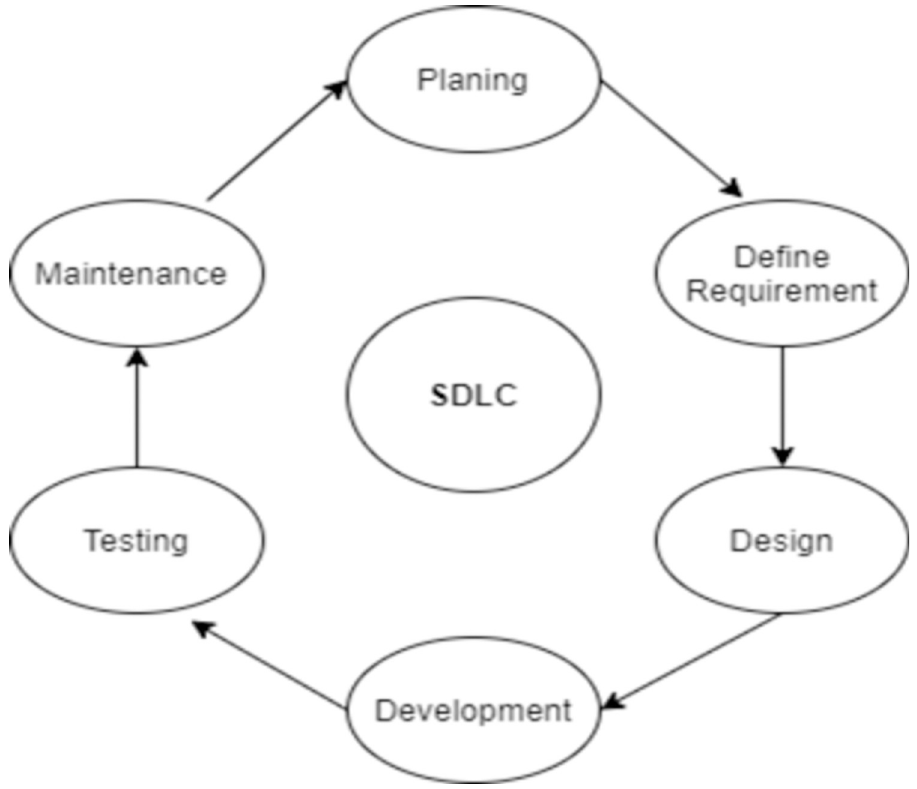
Fig 1. Software development life